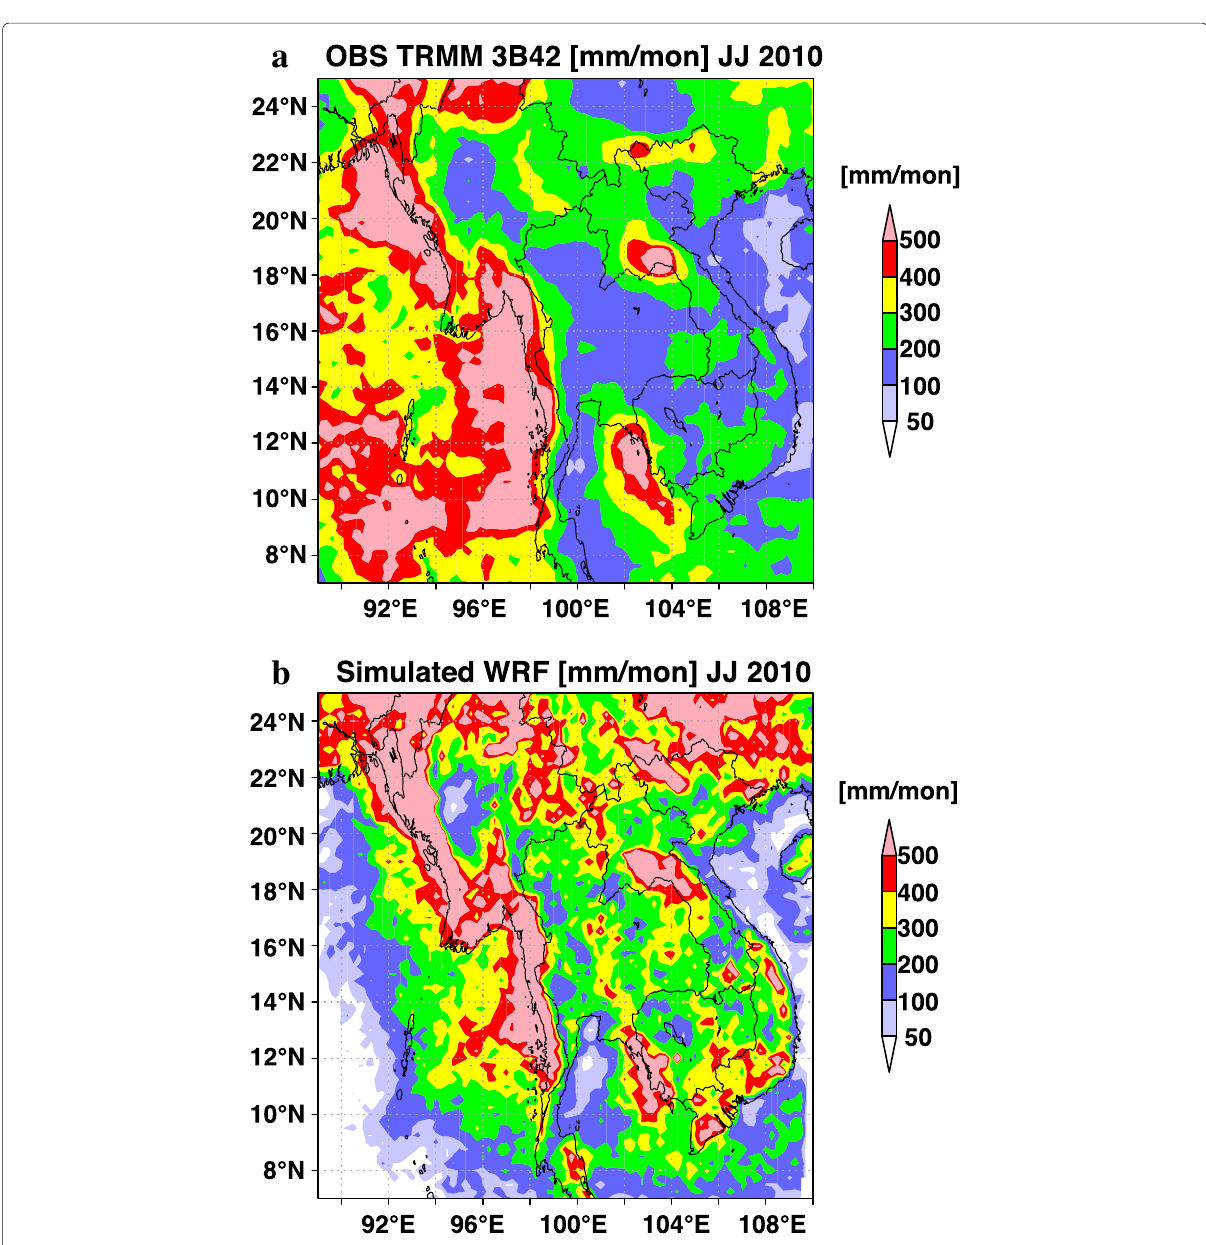
Fig. 2 a Observed (TRMM-3B42) monthly rainfall amount over the study region in June and July of 2010. b Same as the upper panel of Fig. 2 but for simulated monthly rainfall. The unit is mm month −